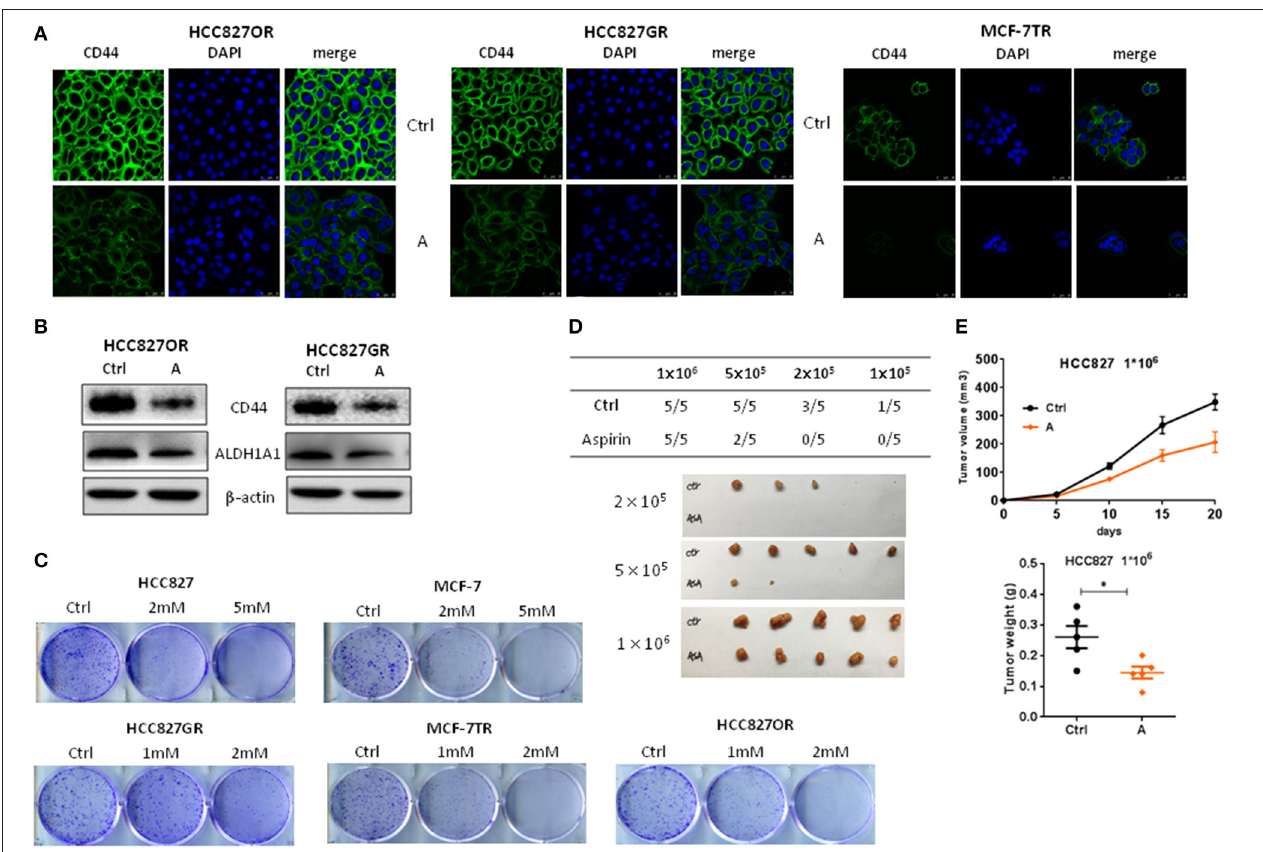
FIGURE 4 | Aspirin suppressed cancer stemness of lung and breast cancers. (A,B) The indicated cells were treated with 1mM aspirin for 72h. CD44 expression was analyzed by immunofluorescence staining (A) . Nuclei were observed with DAPI staining. Scale bar, 50 µ m. (B) The expressions of CD44 and ALDH1A1 were examined by Western blot. (C) Colony formation assay of indicated cells treated with indicated concentrations of aspirin. (D,E) Limiting dilution transplantation assay. HCC827 cells were treated with 2mM aspirin for 12h prior to transplantation. The indicated numbers of viable HCC827 cells were transplanted subcutaneously into nude mice. The incidence and the photograph of tumors (D) . The growth curve and weight of tumors from 1 × 10 6 HCC827 cells (E) . The data are presented as the means ± SEM. Student’s t -test was used. * P <